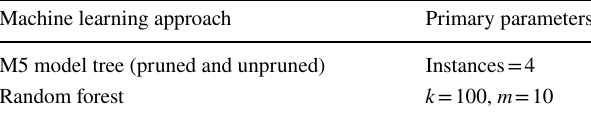
Machine learning approach Primary